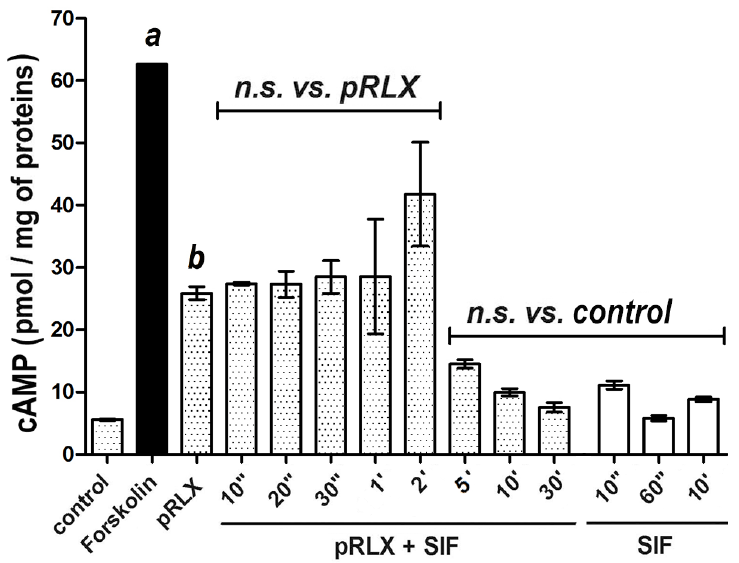
Figure 2. cAMP response by THP-1 cells upon stimulation with porcine relaxin (pRLX) (100 ng/mL) or its digestion products obtained by SIF incubation for up to 30 min. Forskolin (10 − 4 M) was used as positive control to evaluate the maximal cAMP levels. A sudden decrease in cAMP generation can be observed at a time point comprised between 2- and 5-min. SIF alone was devoid of any cAMP-stimulating effects on THP-1 cells. Significance of differences: a,b p < 0.001 vs.